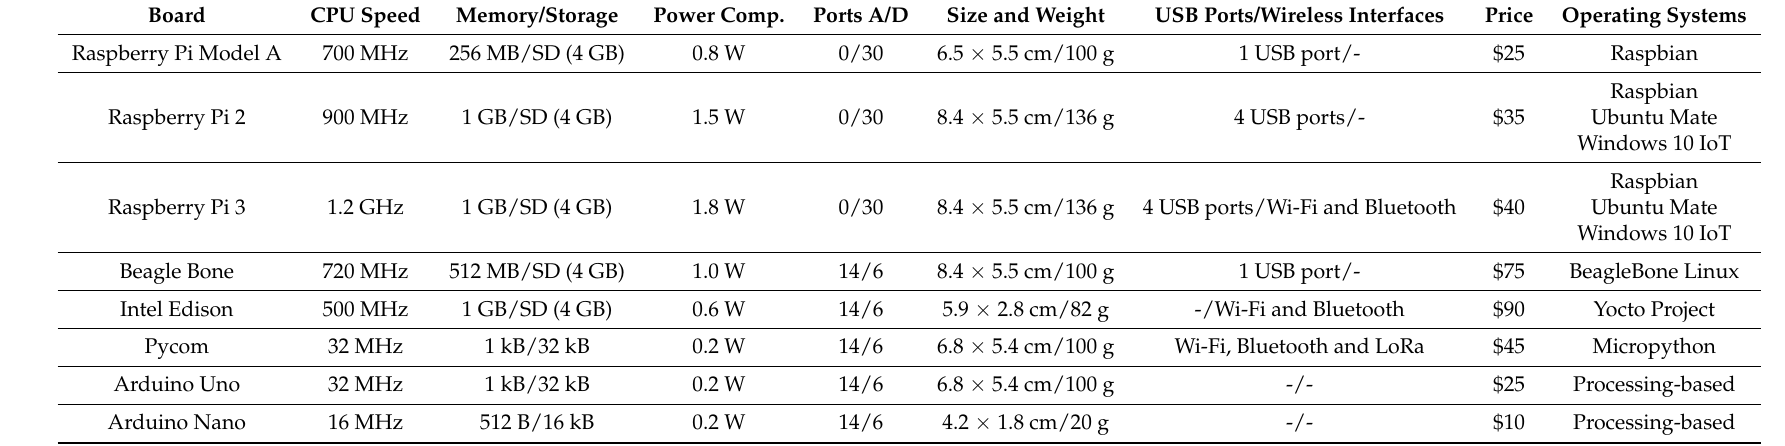
Table 3. Comparison of different processing module